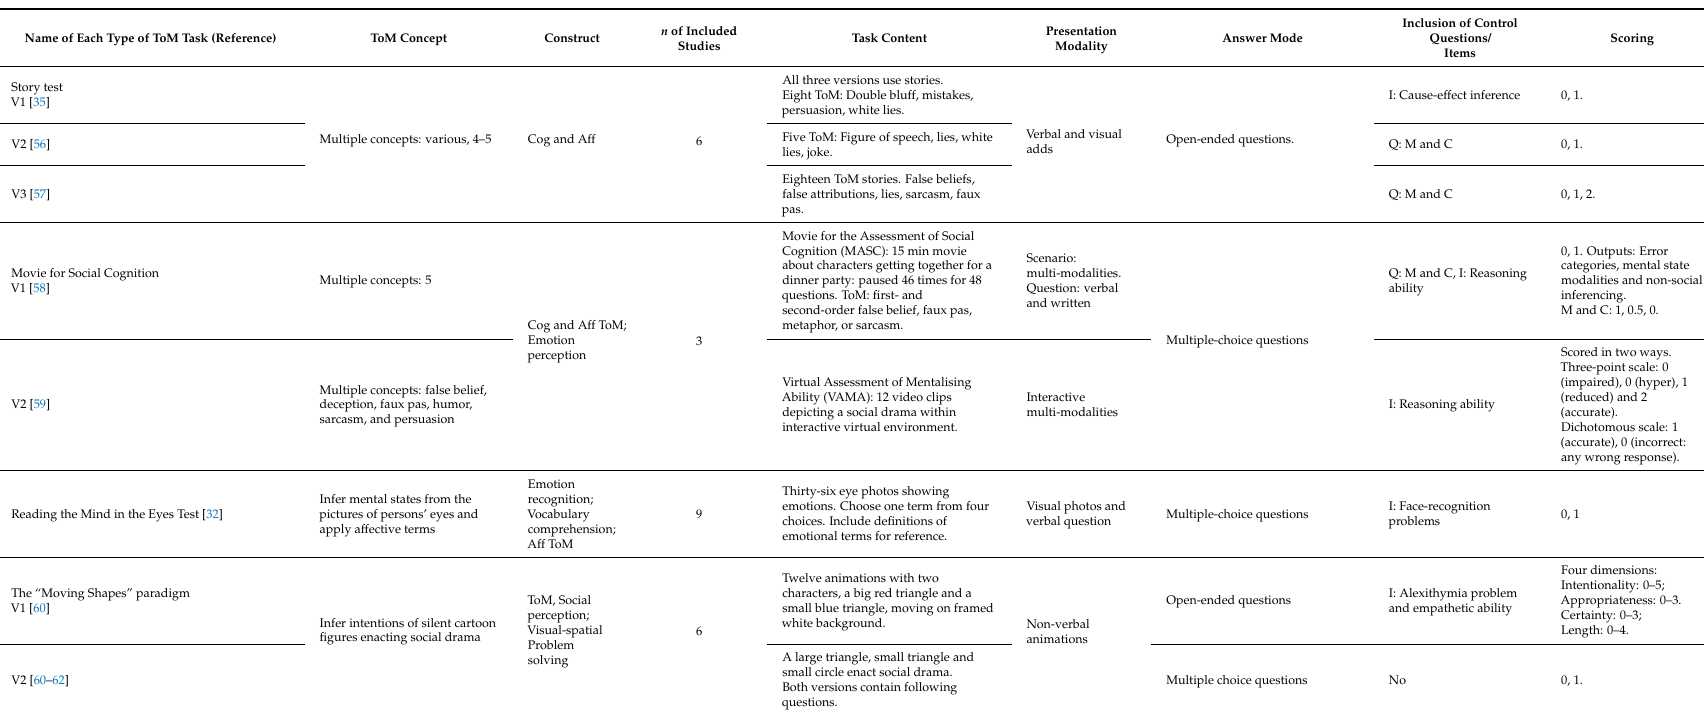
FiveToM:Figureofspeech,lies,white